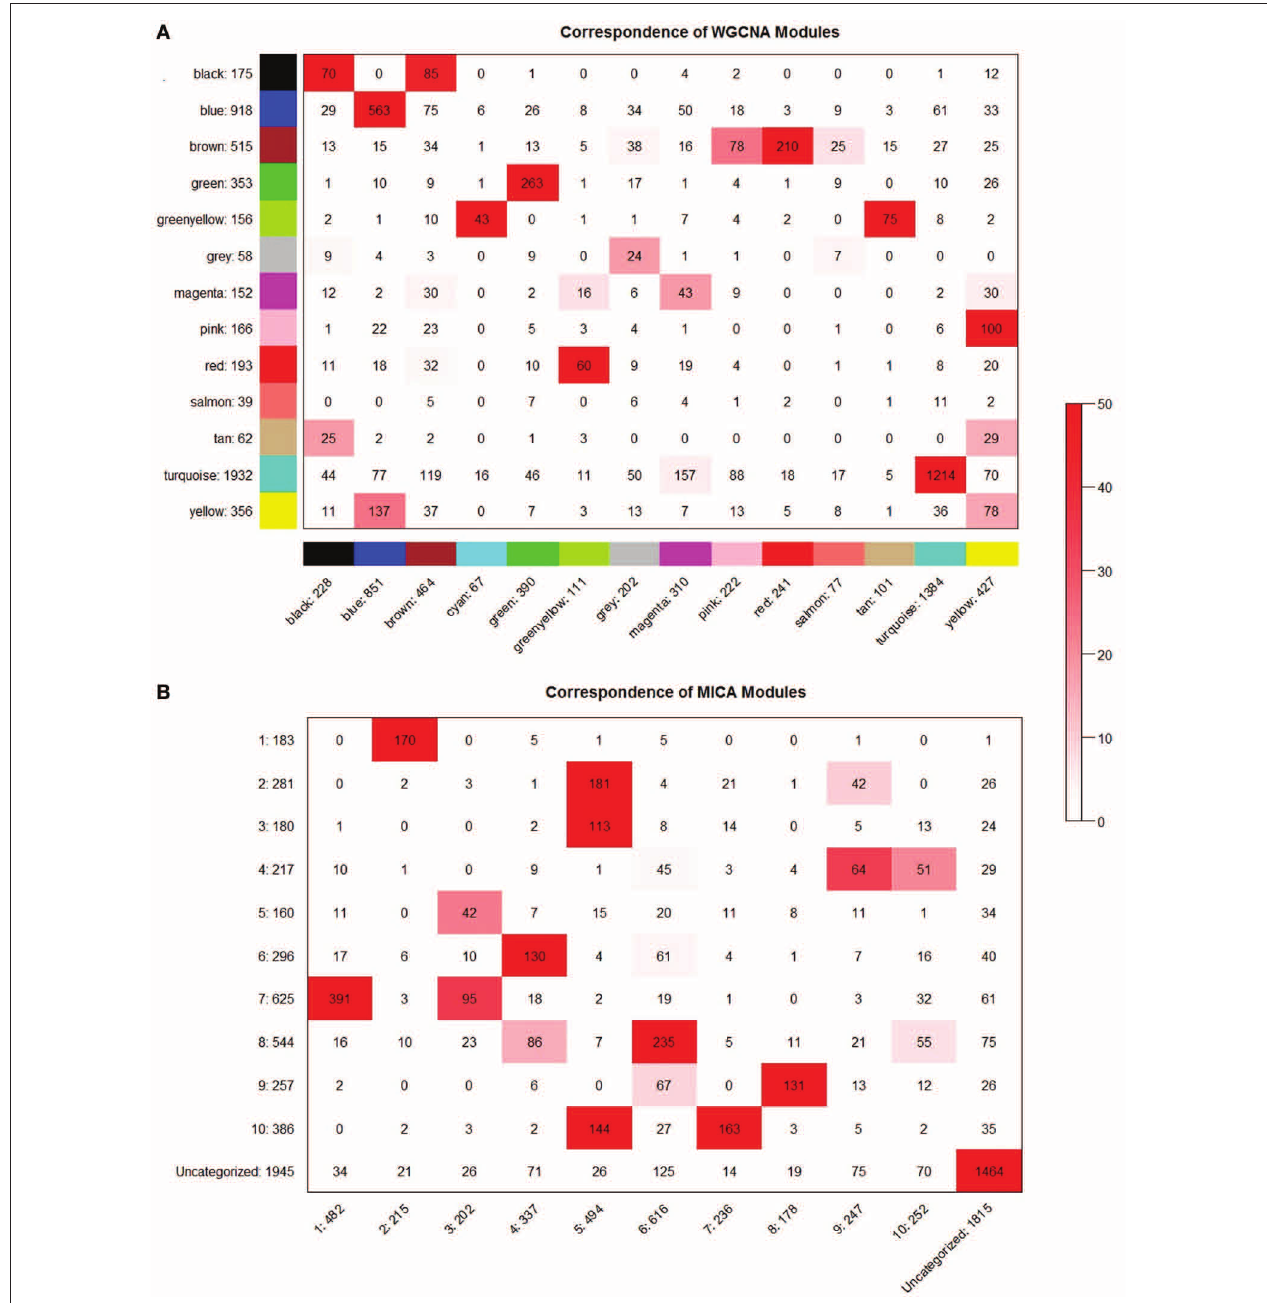
FIGURE 8 | MICA and WGCNA have comparable module preservation statistics. Module preservation between even partitionings of the macrophage dataset for (A) WGCNA and